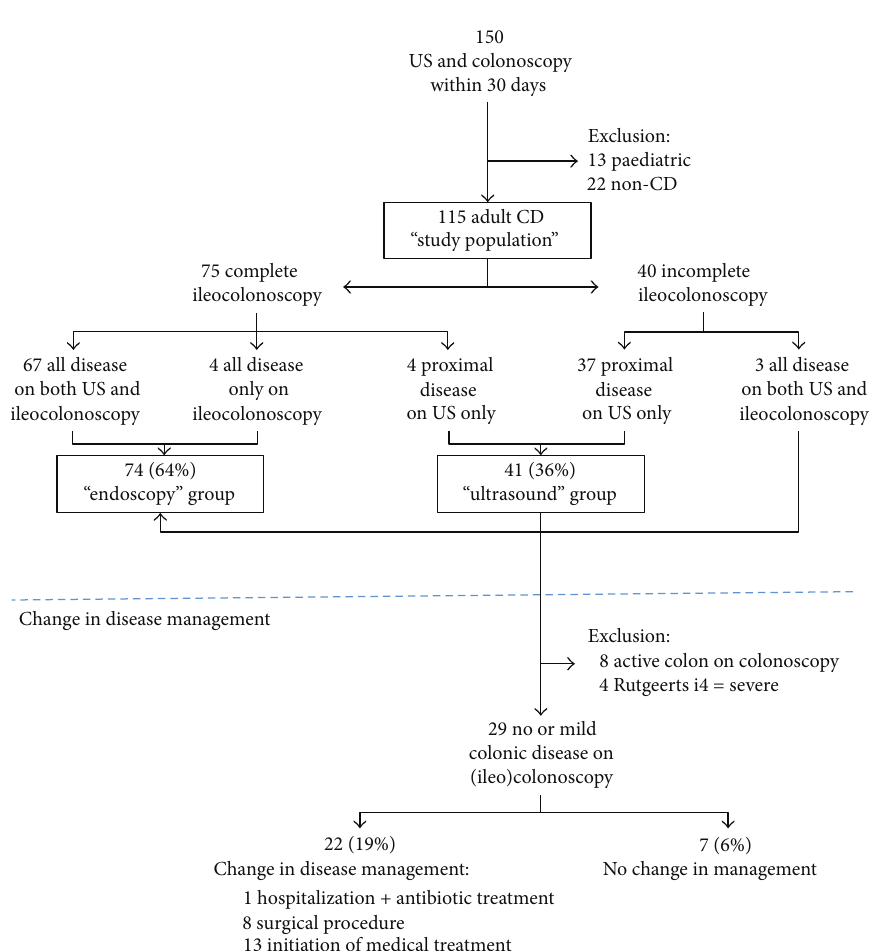
Figure 1: Schematic representation of the study population and change in disease management. 150 patients referred for intestinal ultrasonography (US) for suspected Crohn’s disease (CD) and temporally related colonoscopy. Change in disease management is shown for the ultrasound